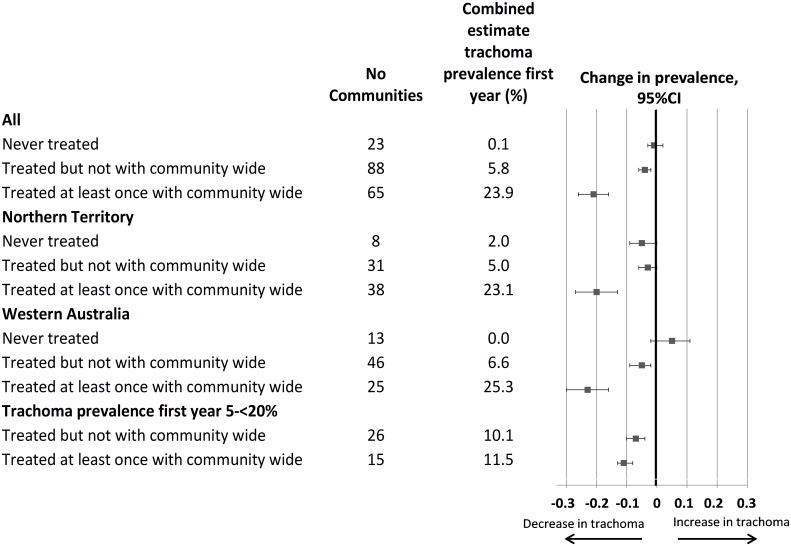
Combined estimate of change in community trachoma prevalence from first to last year of data collection, according to treatment strategy, by jurisdiction, and in subgroup of initial prevalence.